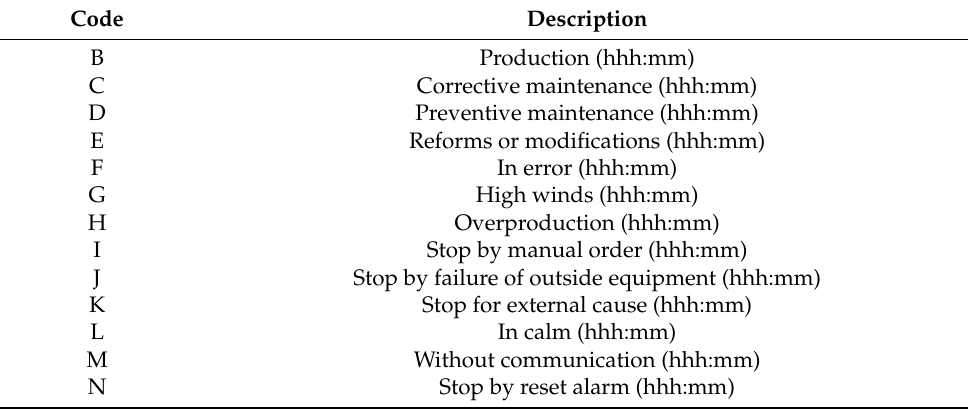
Table 8. Possible operating and error states of a wind turbine. Code